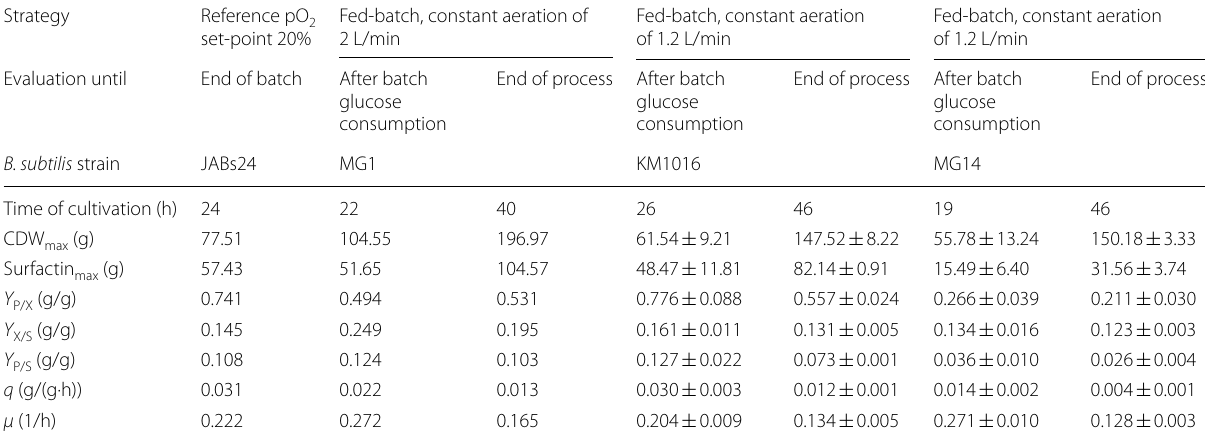
Table 3 Summary of main process data, calculated overall yields and specific growth rates of B. subtilis bioreactor cultivations